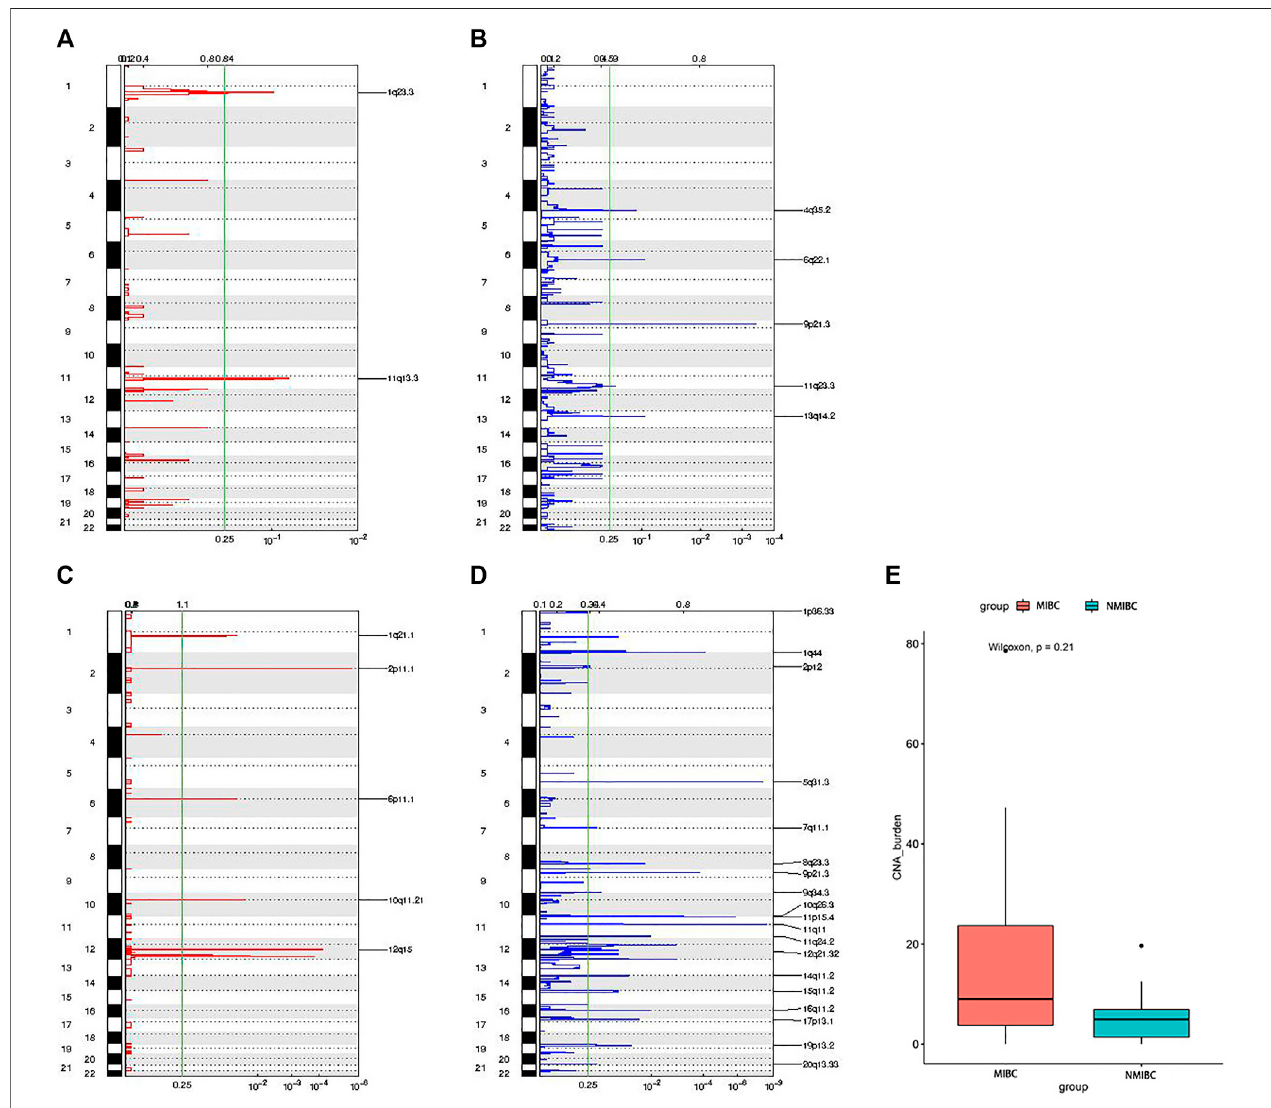
FIGURE 6 | The distribution of locations of CNAs and CNAs burden between MIBC and NMIBC. (A) The locations of ampli fi cations in MIBC; (B) The locations of deletionsinMIBC; (C) Thelocationsofampli fi cationsinNMIBC; (D) ThelocationsofdeletionsinNMIBC; (E) CNAs burdeninMIBCand NMIBC,datawereexpressedas median (interquartile range) and were statistically analyzed by Mann-Whitney U test. CNA: copy number alteration; NMIBC: non-muscle invasive bladder cancer; MIBC: muscle-invasive bladder cancer.